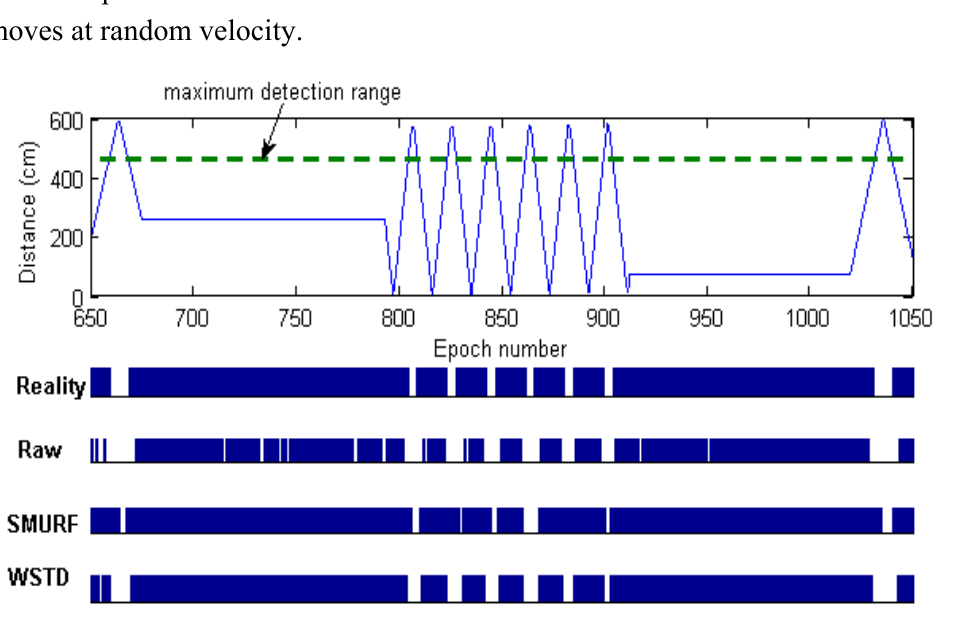
Figure 7. Comparison of WSTD and SMURF schemes’ transition detection mechanisms as a tag moves at random